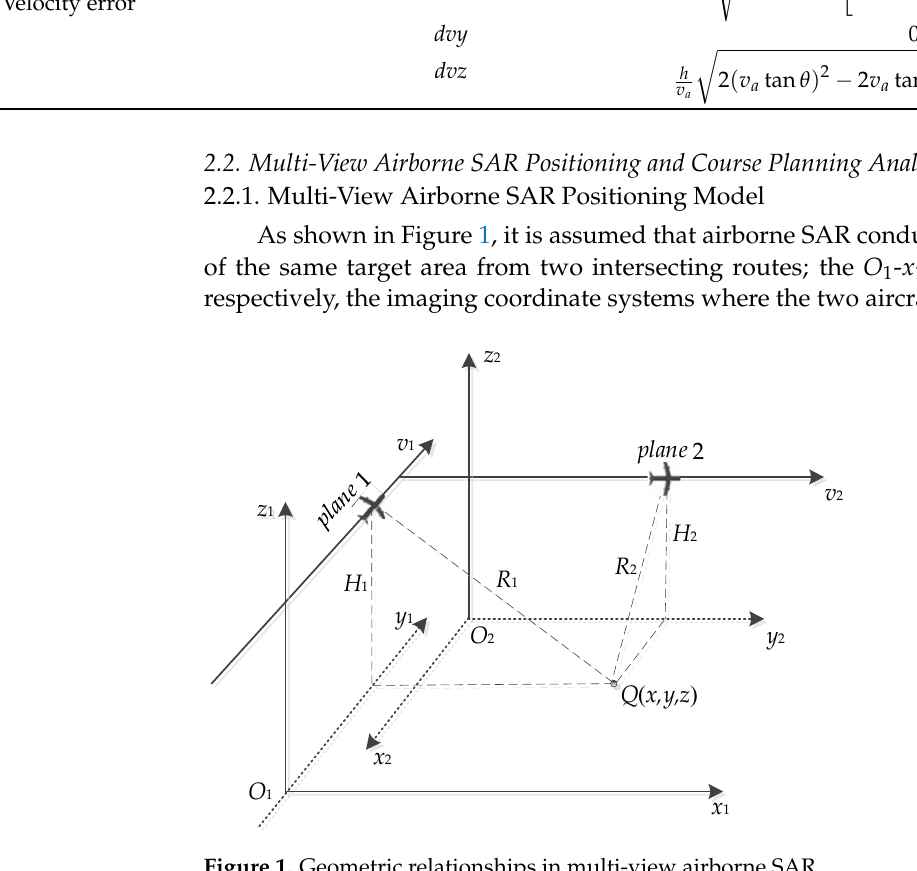
Figure 1. Geometric relationships in multi-view airborne